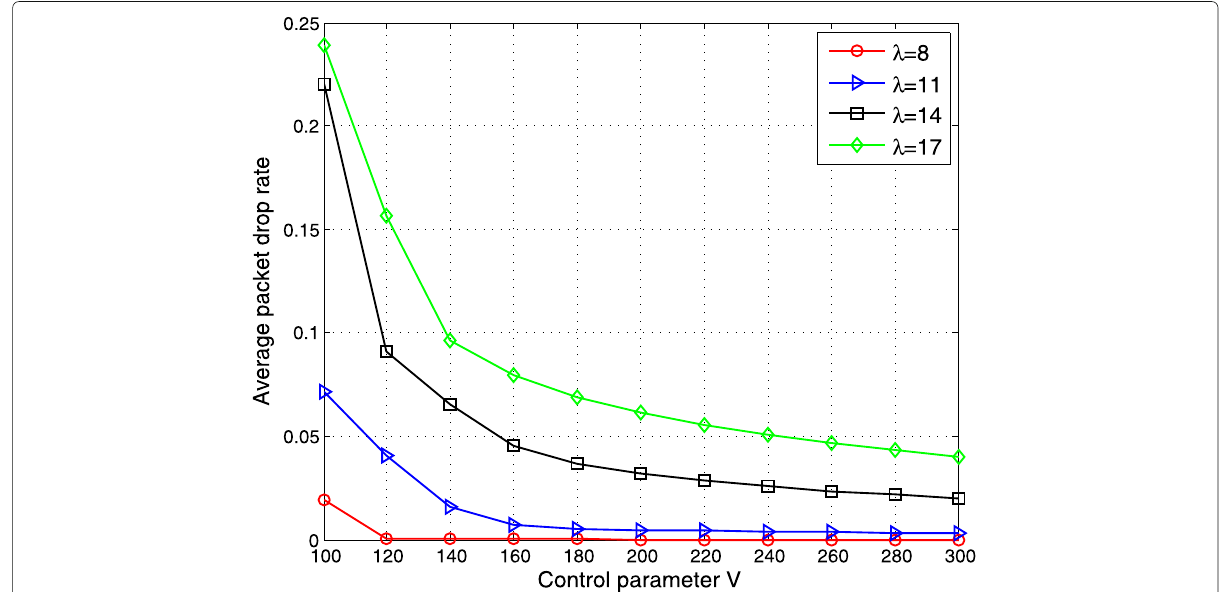
Fig. 3 The average packet drop rate versus the control parameter V with different λ